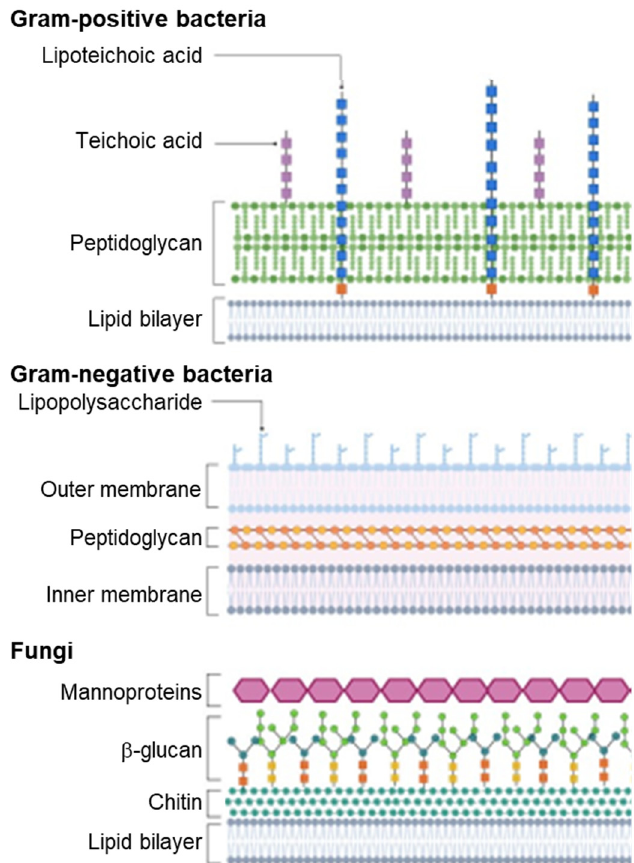
Figure 6. Comparison of fungal and bacterial cells (created with BioRender.com, accessed on 1 August 2022). Gram-positive bacteria and fungi contain glycan layers on the extracellular side of the lipid membrane, while a second membrane encapsulates the peptidoglycan layer in Gram-negative bacteria.